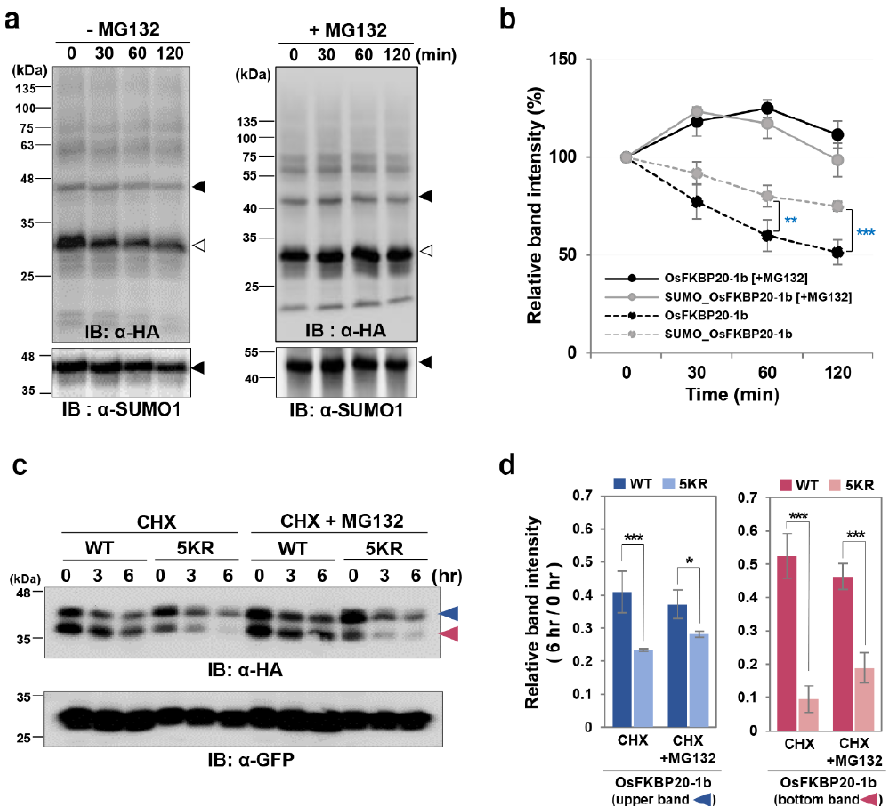
Figure 3. SUMOrylaed OsFKBP20-1b enables maintain the stability both in vitro and in vivo. ( a ) Degradation of recombinant WT and 5KR_OsFKBP20-1b proteins with HA tag in cell extracts of plants. Purified WT_OsFKBP20-1b and 5KR_OsFKBP20-1b proteins (2 μ g) were incubated with cell extracts (30 μ g) isolated from 7-day-old rice seedlings for indicated times at 25 °C with/without 50 μ M MG132. OsFKBP20-1b protein levels were detected by immunoblot (IB) using anti - HA antibod- ies. ( b ) SUMOylated OsFKBP20-1b (black arrow head) and non-SUMOylated OsFKBP20-1b (white arrow head) bands were detected by immunoblot assay at ( a ) and were calculated using ImageJ software. The data are represented as values which were normalized to time zero (baseline). Error bar indicates ± SE of three repeated experimental data sets. ( c ) In vivo degradation of WT and 5KR_OsFKBP20-1b proteins through transient expression in N. benthamiana leaves. GFP and HA tagged WT or 5KR_OsFKBP20-1b protein was transiently expressed by A. tumefaciens infiltration. At 2 days after infiltration, total proteins extracted from tobacco leaves and treated CHX with (CHX + MG132) or without MG132 (CHX) for 0, 3 and 6 h. There are two bands for OsFKBP20-1b, ◄ indicates upper band; ◄ indicates lower band. The protein expression was detected by immunoblot assay. GFP was used for control for transient protein expression level. ( d ) Relative WT_OsFKBP20- 1b and 5KR_OsFKBP20-1b degradation levels in vivo. The band intensities of WT_ and 5KR_OsFKBP20-1b at 6 h was divided to 0 h band using ImageJ program. Error bar indicates ± SE of three times repeated experimental data sets. Student’s t -test; * p -value < 0.1, ** p -value < 0.05, *** p -value < 0.01.